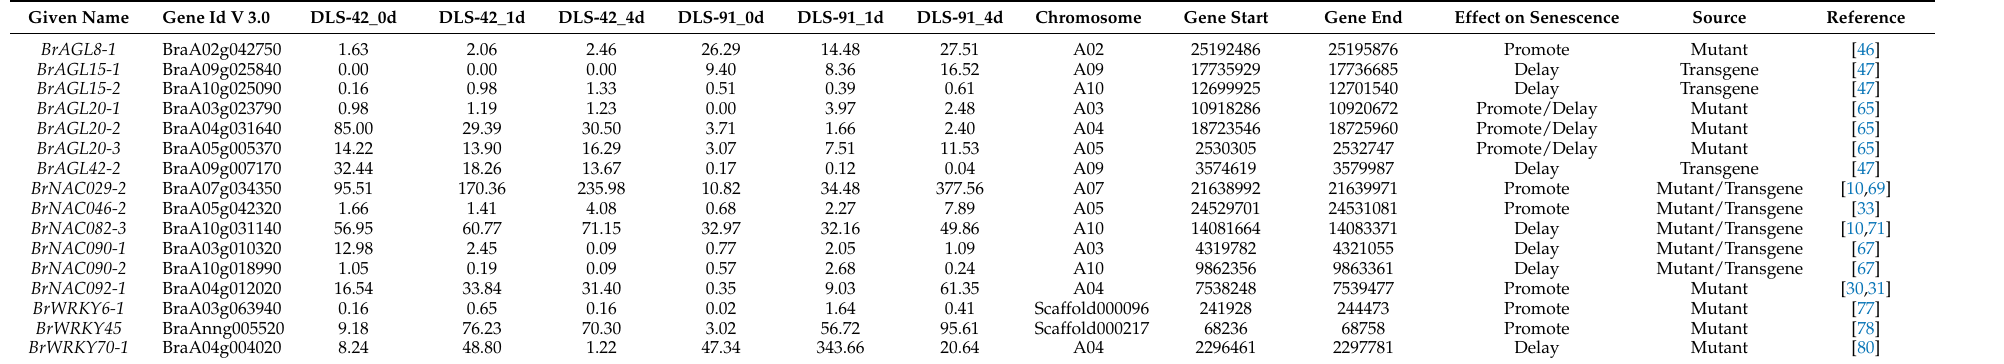
Table 2. Annotations of genes selected for qRT-PCR validation and their senescence-related